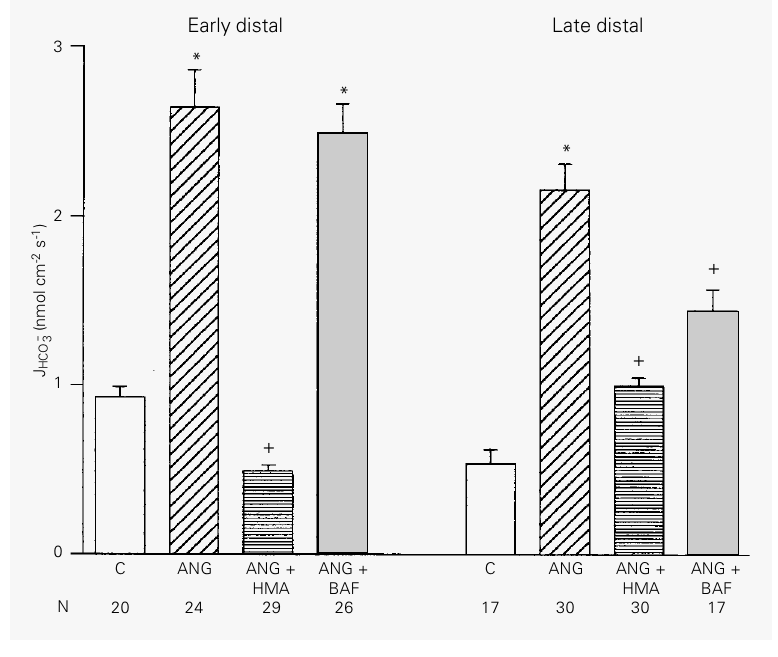
Figure 4 - Velocity of pH recov- ery (dpH i /dt) in MDCK cells sub- jected to increasing angiotensin II concentrations (1 pM, 1 nM and 100 nM) alone or in the presence of atrial natriuretic pep- tide (ANP, 1 (cid:181)M). The experi- ments were done in the pres- ence (145 mM) or absence of Na + . *P<0.05 compared to con- trol (C); + P<0.05 compared to ANG II (Bonferroni